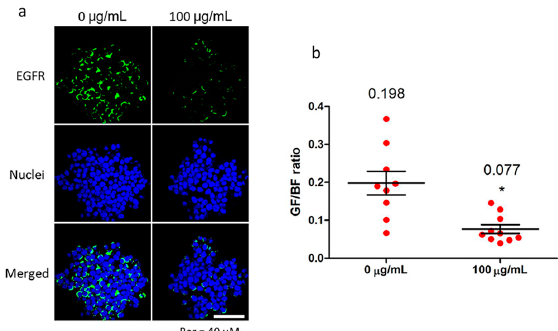
Figure 6. Fullerenol reduces extracellular domain targeted anti-epidermal growth factor receptor (EGFR) antibody binding. Freshly isolated oocyte-granulosa cell complexes (OGCs) were quickly fixed for immunofluorescent staining. During the standard procedure, OGCs were exposed to 100 μ g/mL fullerenol for 10 min, and then gently washed before incubation with primary antibody. ( a ) Representative images of EGFR immunofluorescently labeled with an extracellular domain-targeted antibody; ( b ) Relative quantitative analysis of EGFR fluorescence intensity ( n = 9–10 views) normalized to fluorescence intensity of nuclei. Green and blue indicate EGRF and nuclei, respectively. GF, green fluorescence intensity (EGFR). BF, blue fluorescence intensity (nuclei). Scale bar: 40 μ m. Mean values are presented in quantitative image. Data are mean ± standard error of the mean (SEM); * p < 0.05 compared with the control.